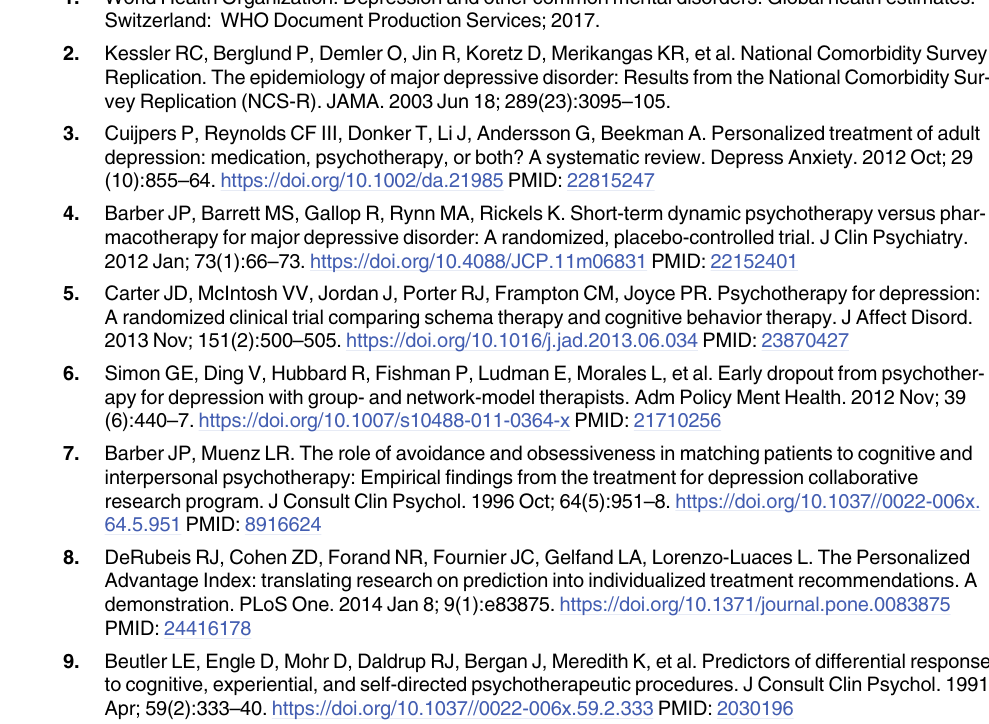
S2 Fig. Sixteen categories of male participants. D symptoms and rumination, prior stressors, and ongoing stressors respectively. (TIF) S1 Table. Model formulations.